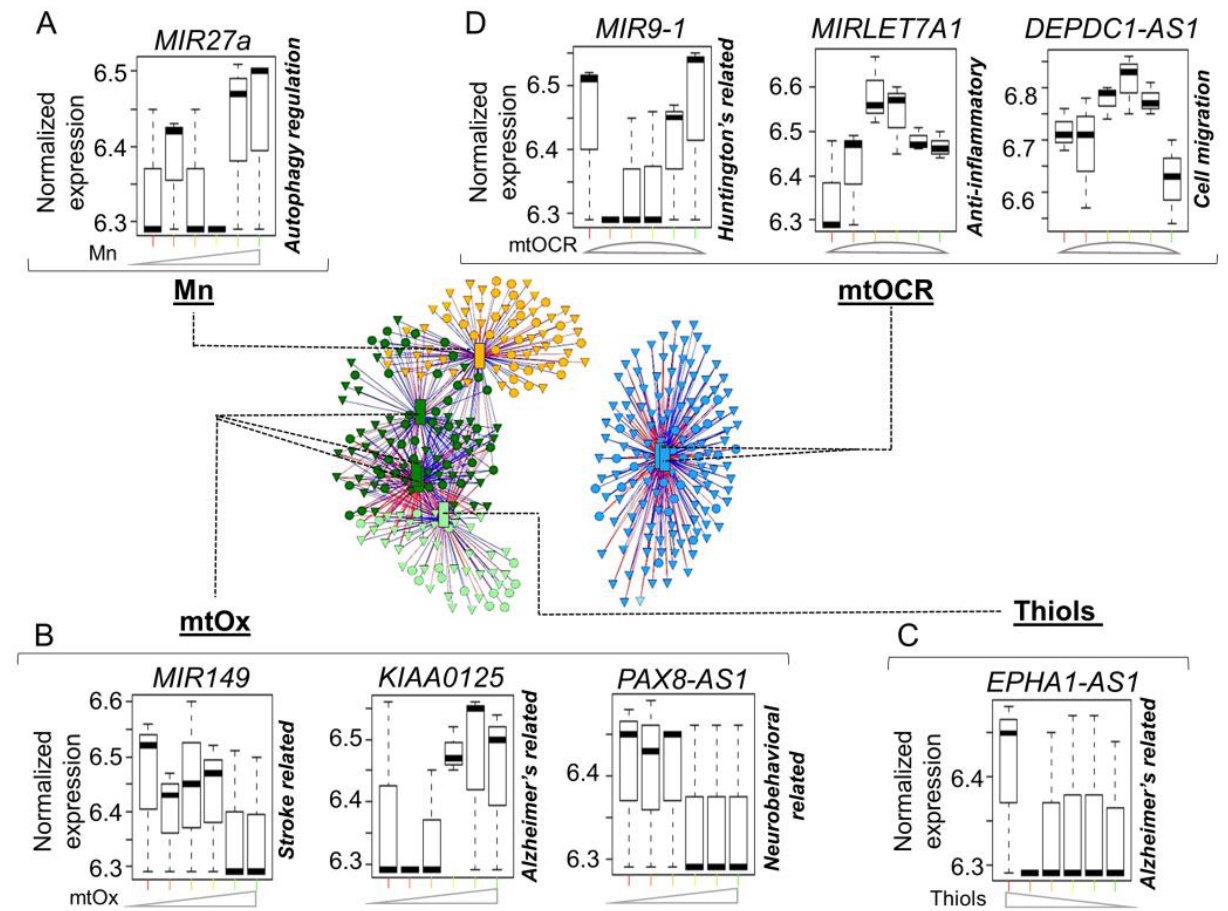
Figure 6. Non-coding RNAs characterized in neurological disorders associated with mitochondrial-cellular parameters in response to Mn dose . ( A ) Environmental stressor (Mn) subnetwork includes positively associated miRNA involved in regulation of autophagy-related protein PINK1, MIR27a . ( B ) Oxidative phosphorylation (mtOCR) subnetwork includes Huntington’s disease-related miRNA, MIR9 - 1 ; anti-inflammatory-related miRNA, MIRLET7A1 ; and cell migration-related lncRNA, DEPDC1 - AS1 . ( C ) Total cellular thiols subnetwork includes positively associated Alzheimer’s-related lncRNA, EPHA1 - AS1 . ( D ) Mitochondrial oxidative stress (mtOx) subnetwork includes stroke-related miRNA, MIR149 , Alzheimer’s-related lncRNA, KIAA0125 and neurobehavioral-associated lncRNA, PAX8 - AS1 . The intensity for functional measures on the x -axis is indicative of Mn exposure low–med–high from left to right. Details on all associated non-coding miRNAs and lncRNAs are provided Tables S1, S3, S5 and S6. |r| > 0.8, p <